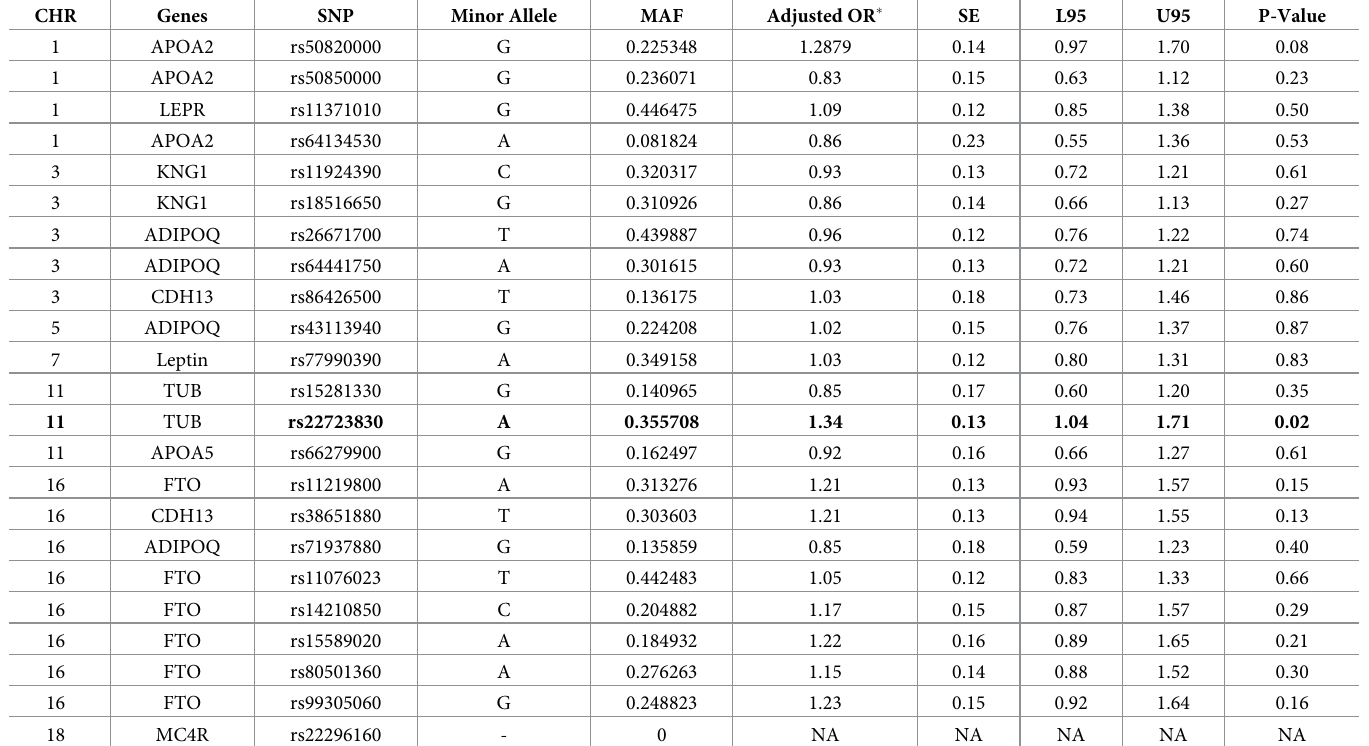
Table 3. Multivariable analysis of BMI groups in